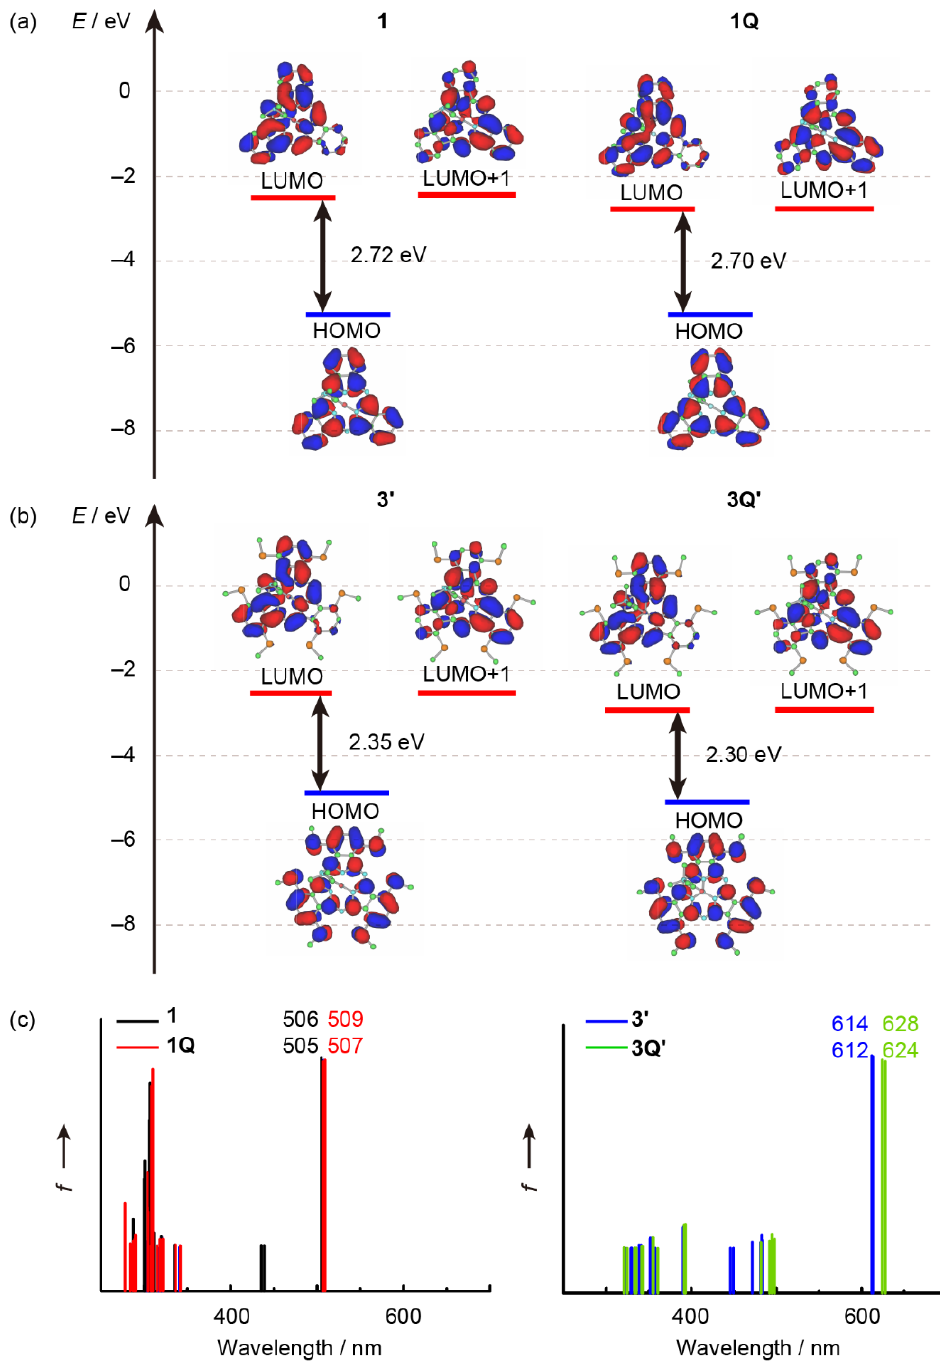
Figure 7. Partial molecular energy diagram and orbitals of ( a ) peripherally unsubstituted SubPcs ( 1 and 1Q ), ( b ) peripherally substituted (MeS) 6 SubPcs ( 3 ′ and 3Q ′ ), and ( c ) their calculated absorption spectra. Calculations were performed at the B3LYP/6-31G* level of theory, using a polarizable continuum model (PCM), which mimicked the solvation effect of dichloromethane. (Details in Supplementary